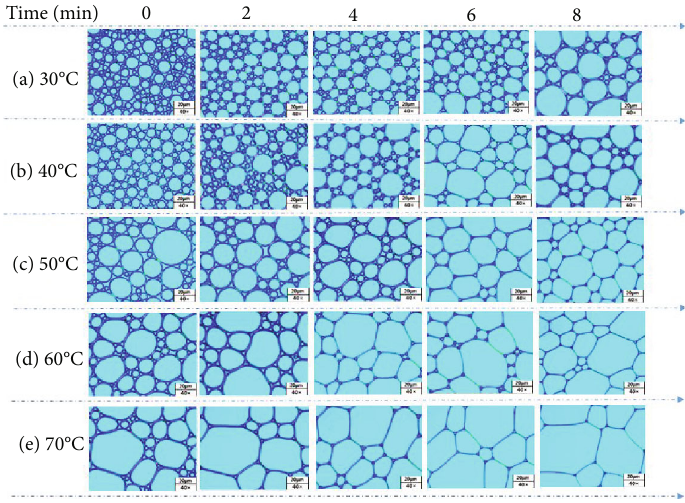
Figure 5: Microphotographs of foam changes with time. Table 5: E ff ects of NaCl concentrations on the foam abilities of di ff erent surfactants at room temperature. The initial foam volume (mL) NaCl concentration (mg · L -1 )